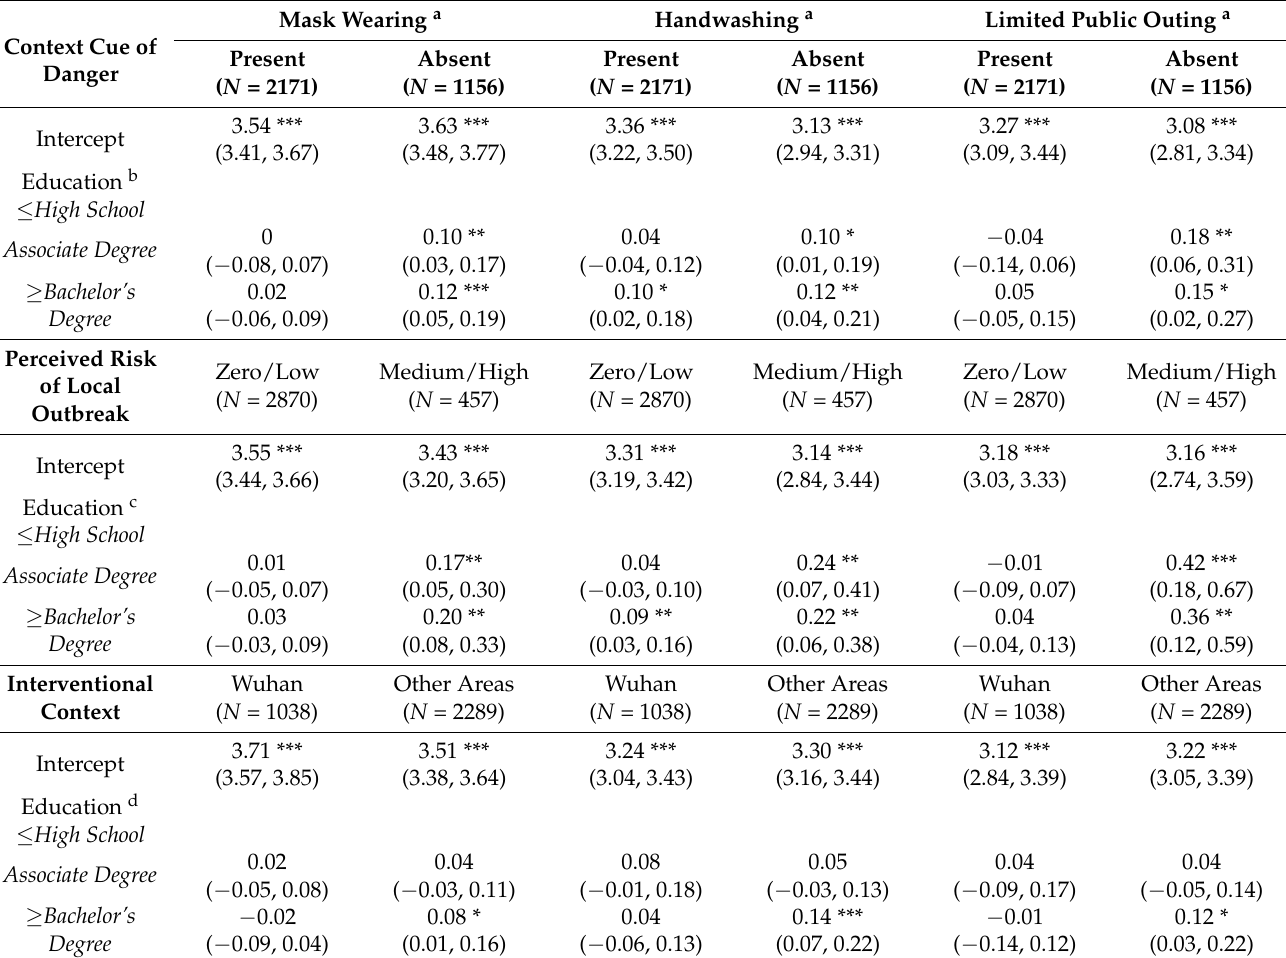
Table 2. Educational Disparities in COVID-19 Preventive Behaviors Stratified by Context Cues of Danger, The Chinese Survey of COVID-19 Impacts 2020 ( N =